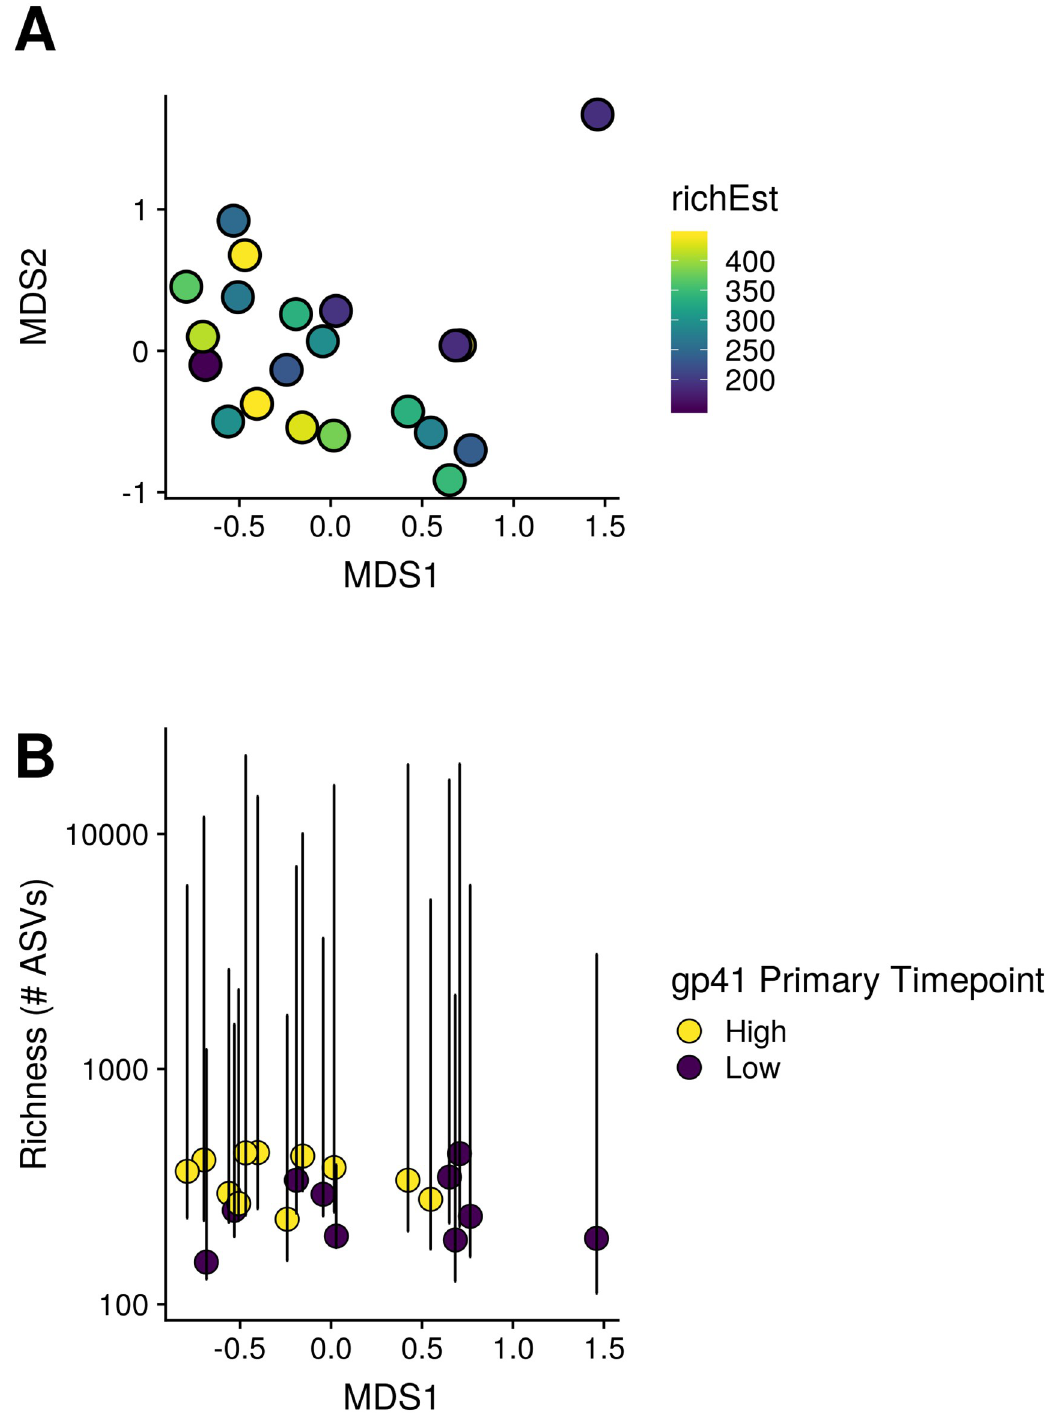
Fig 3. Visualization of the relationship between weighted unifrac distance, estimated richness and immunogenicity. A. The relationship between weighted unifrac distance and richness shown with principal coordinates axes. Positions of points are the same as in Fig 2, but color coding reflects species richness estimates. B. Relationship between MDS1 (x-axis), species richness, y- axis, and median split gp41 immunogenicity at the primary 6.5 month timepoint point. Error bars indicate standard errors of the richness